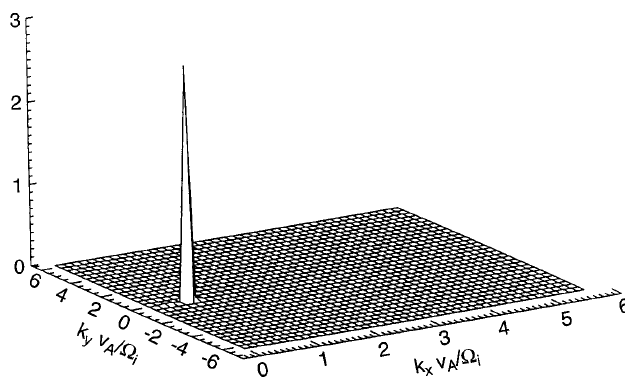
Fig. 5. The power spectrum of B y in